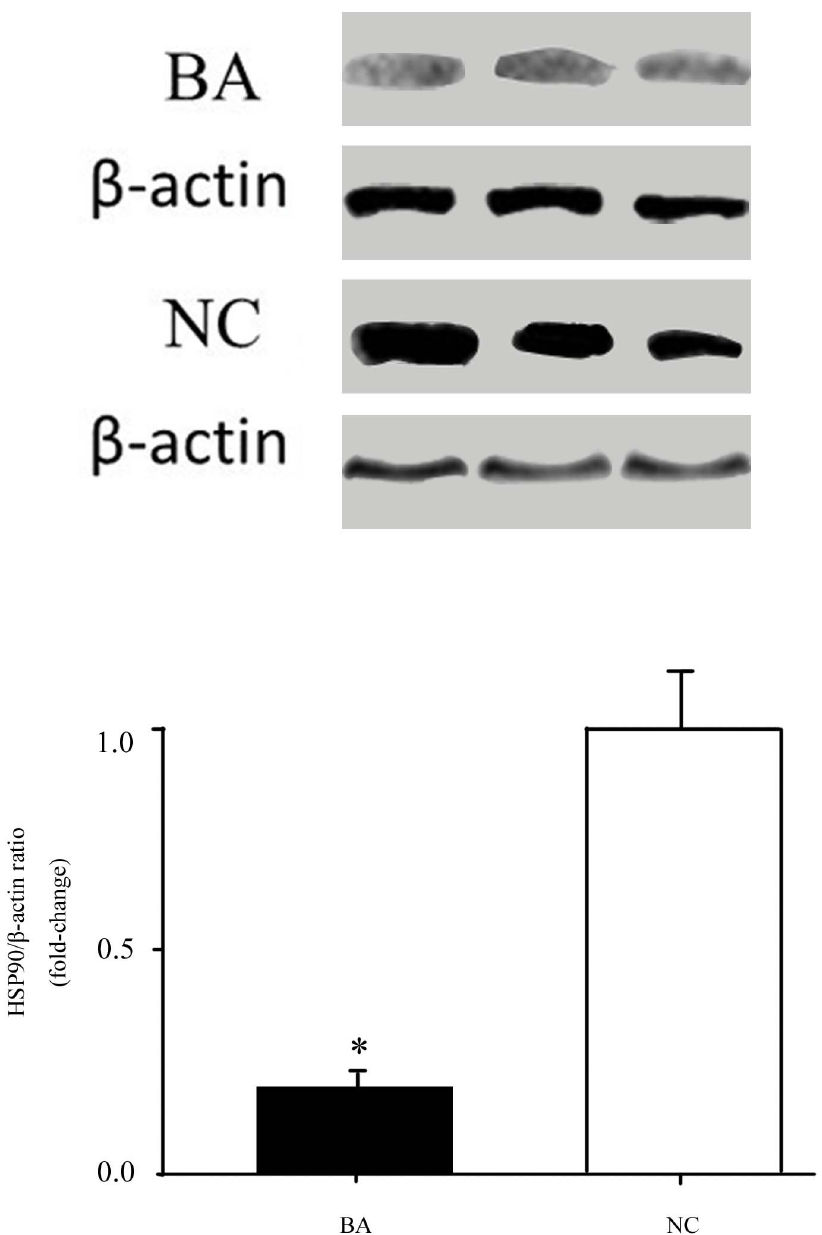
Figure 3. Immunoblotting analysis of HSP90 protein expression. HSP90 protein expression (HSP90/ b -actin ratio) was significantly lower in BA infants (53279 6 3408) than NC controls (276669 6 19421) ( p =0.03). BA: biliary atresia; NC: non-BA neonatal cholestasis infants.